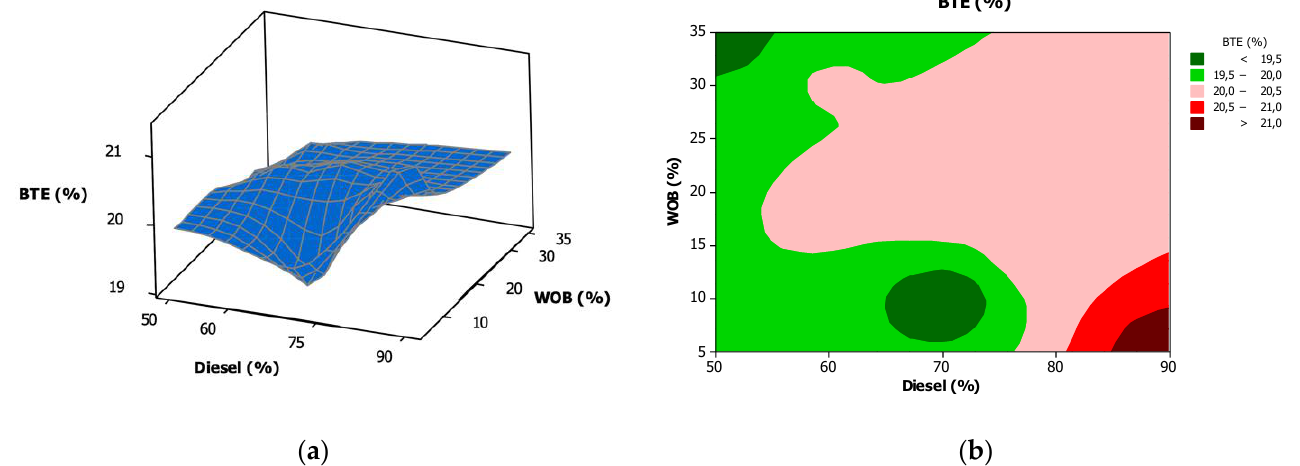
Figure 3. ( a ) Surface plot; ( b ) Contour plot of BTE with input variables.